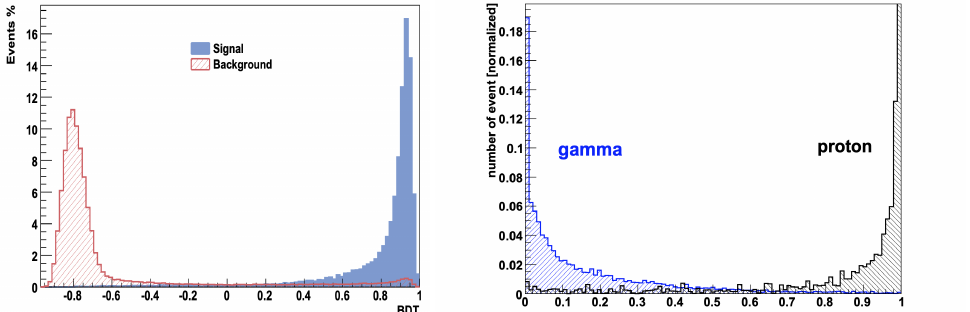
Figure 3. Left panel : distribution for background events (hatched red) and simulated γ (blue filled) of the discriminating variable given in output from the BDT method implemented by the HESS collaboration. Reprinted with permission from ref. [30] Copyright 2010 Fiasson et al. Right panel : distribution for background events (black) and simulated γ (blue) of the discriminating variable (called hadronness ) given in output from the RF method implemented by the MAGIC collaboration. Reprinted with permission from Ref. [33] Copyright 2009 Colin et